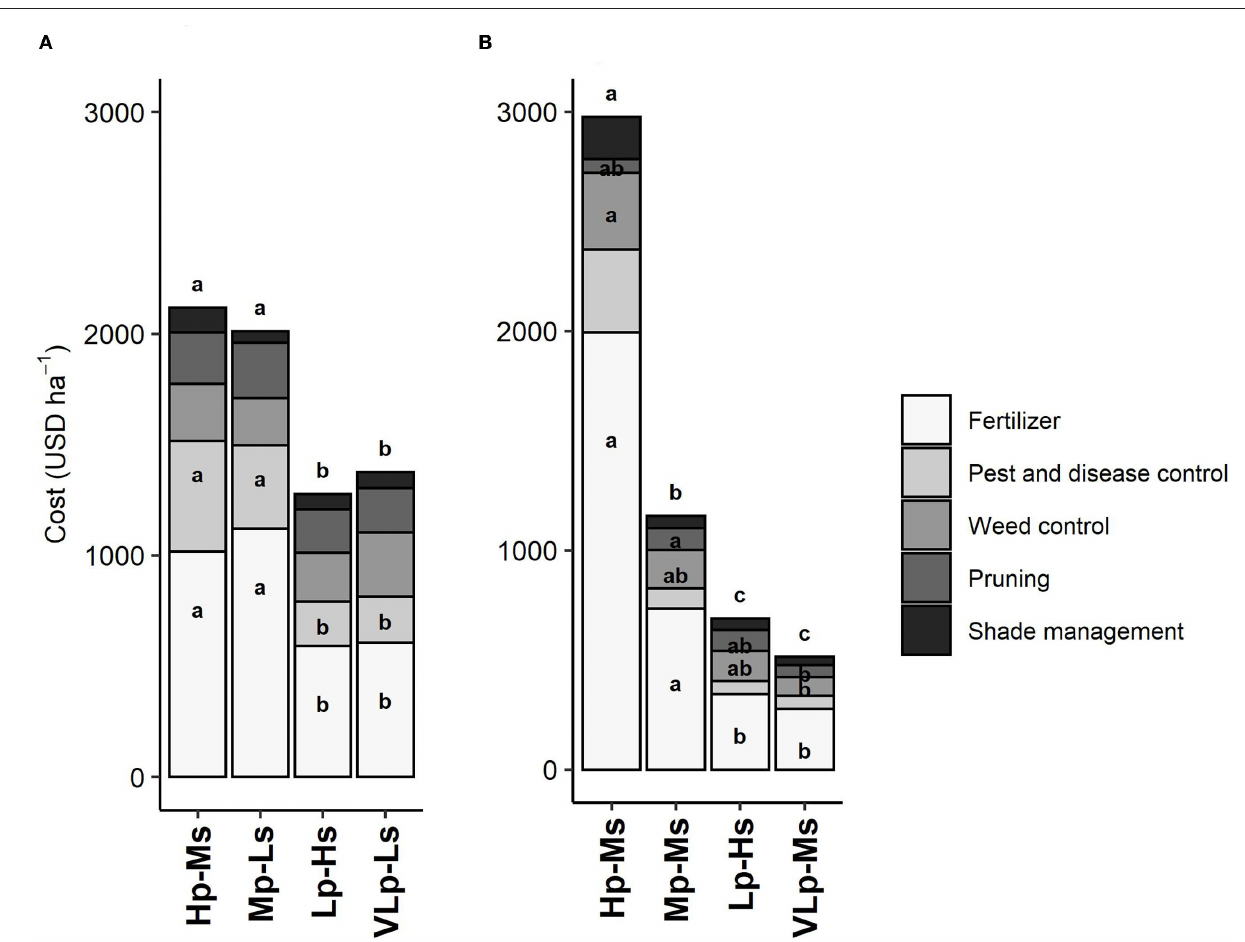
Means within a row with a common letter are not significantly different (p > 0.05).